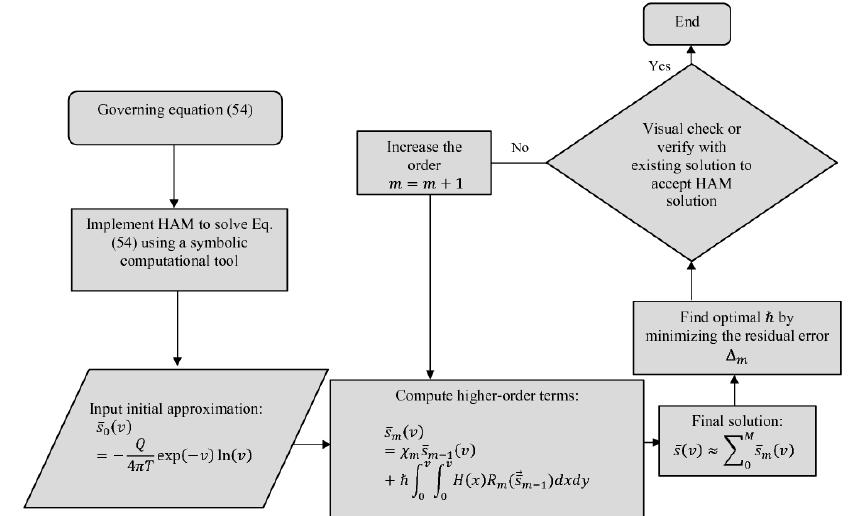
Figure 7. Flowchart for the HAM solution